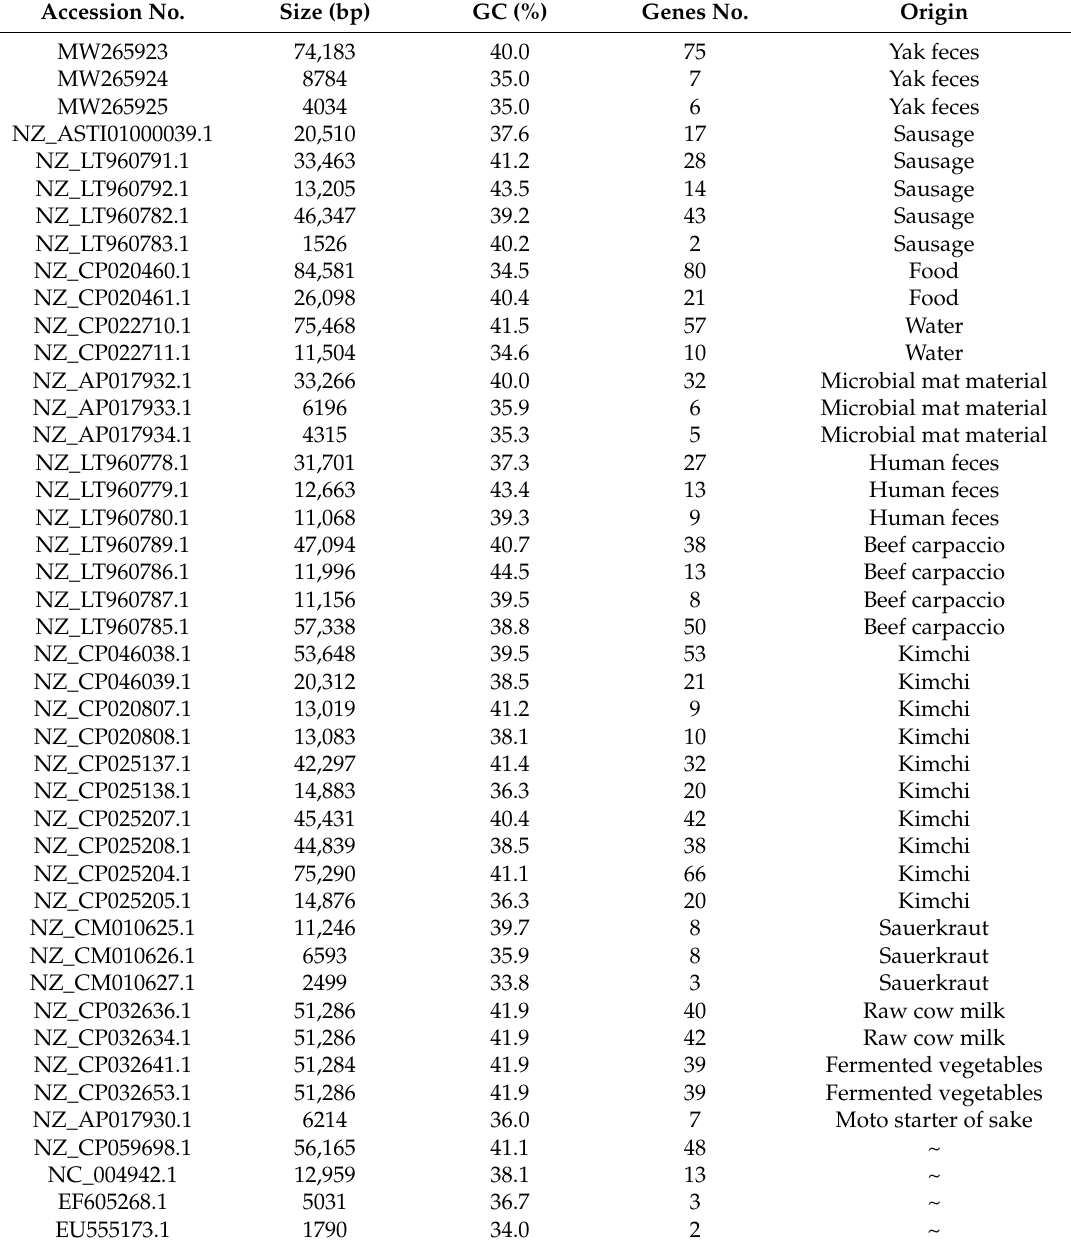
Table 5. Characteristics’ analysis of L. sakei